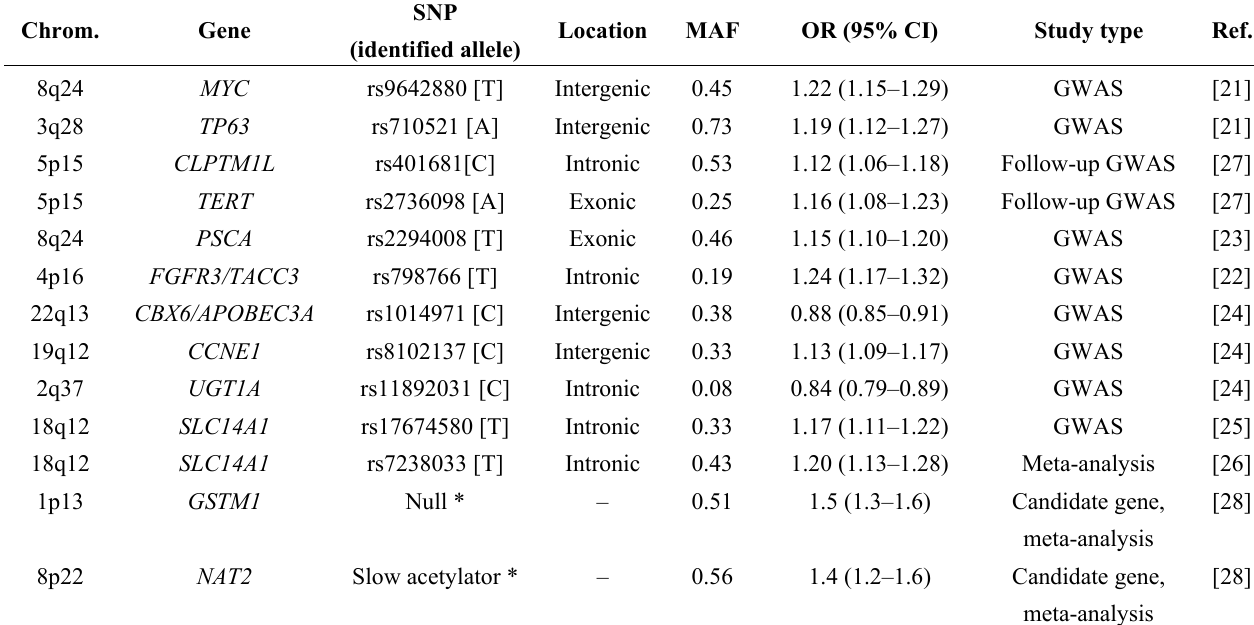
Table 1. Urinary bladder cancer risk